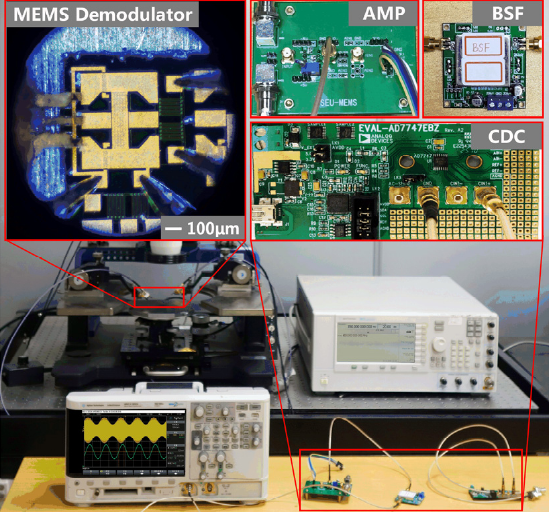
Figure 7. Test setup and inset: MEMS demodulator and its processing circuit.